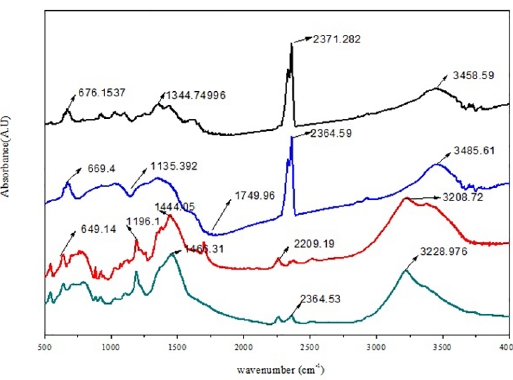
Figure 3. FTIR spectra of prepared glass